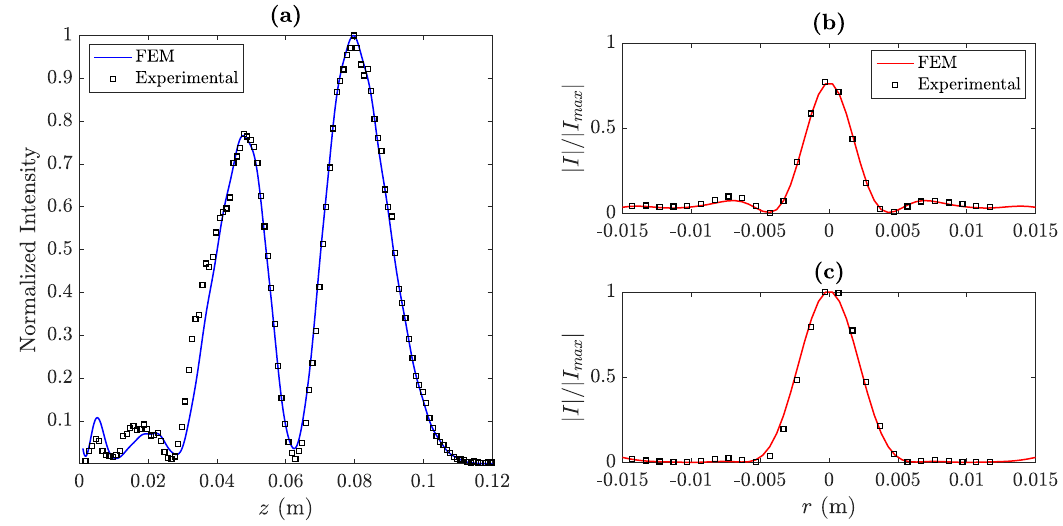
Figure 7. ( a ) Measured (black squares) and simulated (blue line) focusing profiles (longitudinal cuts) for the manufactured BiFZP lens. ( b,c ) Measured (black squares) and simulated (red lines) transversal cuts at z = F (cid:48) ( b ) and z = F (cid:48) ( c ). 2 1